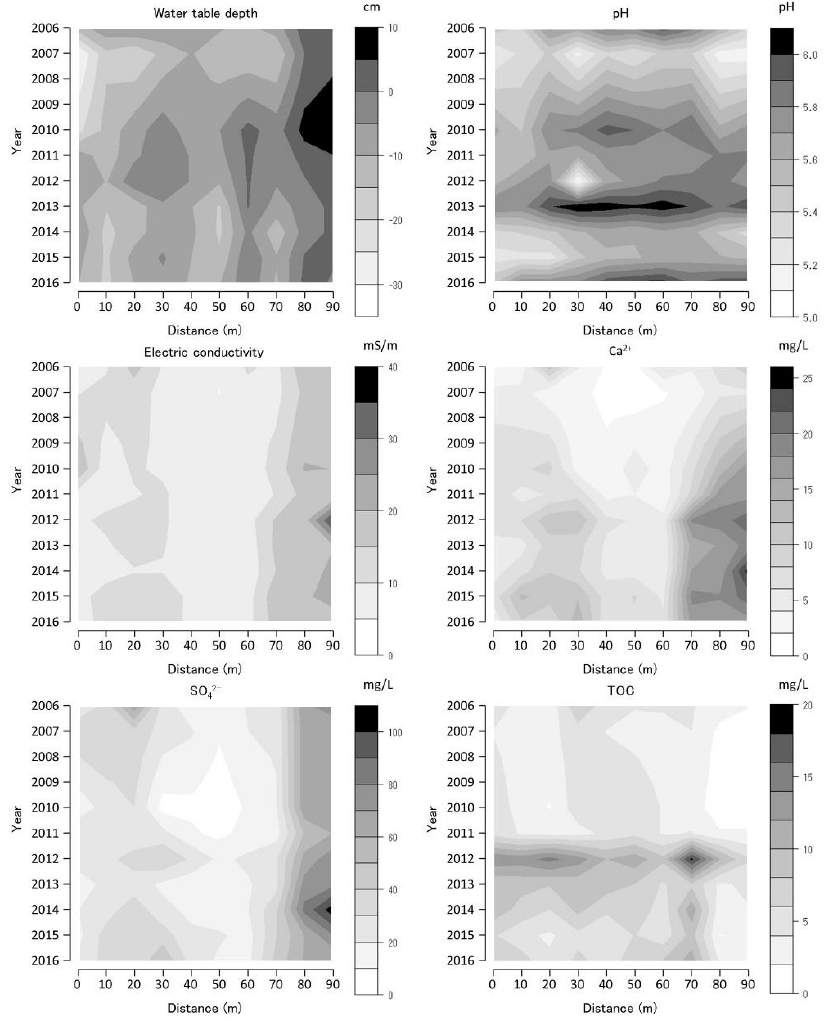
Figure 8. Water-table depth (WTD), pH, electric conductivity (EC), calcium ion concentration (Ca 2+ ), sulfate ion concentration (SO 42 − ), and total organic carbon (TOC) along Bougatsuru transect 2 (BGT transect 2). Data were collected at 10 sites of water environment monitoring with 10 m intervals along the transect. Countered figures of chemical variables on the axes of year and position were drawn by interpolating missing data (in 2008 and 2009)